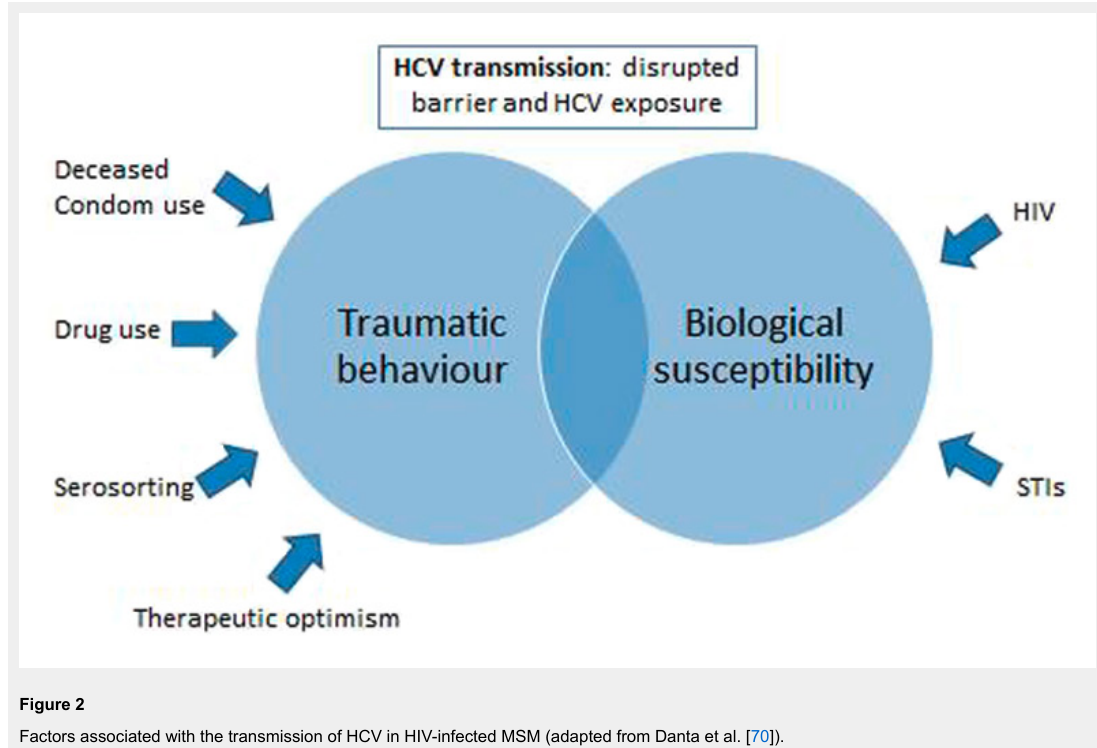
Figure 2 Factors associated with the transmission of HCV in HIV-infected MSM (adapted from Danta et al. [70]).